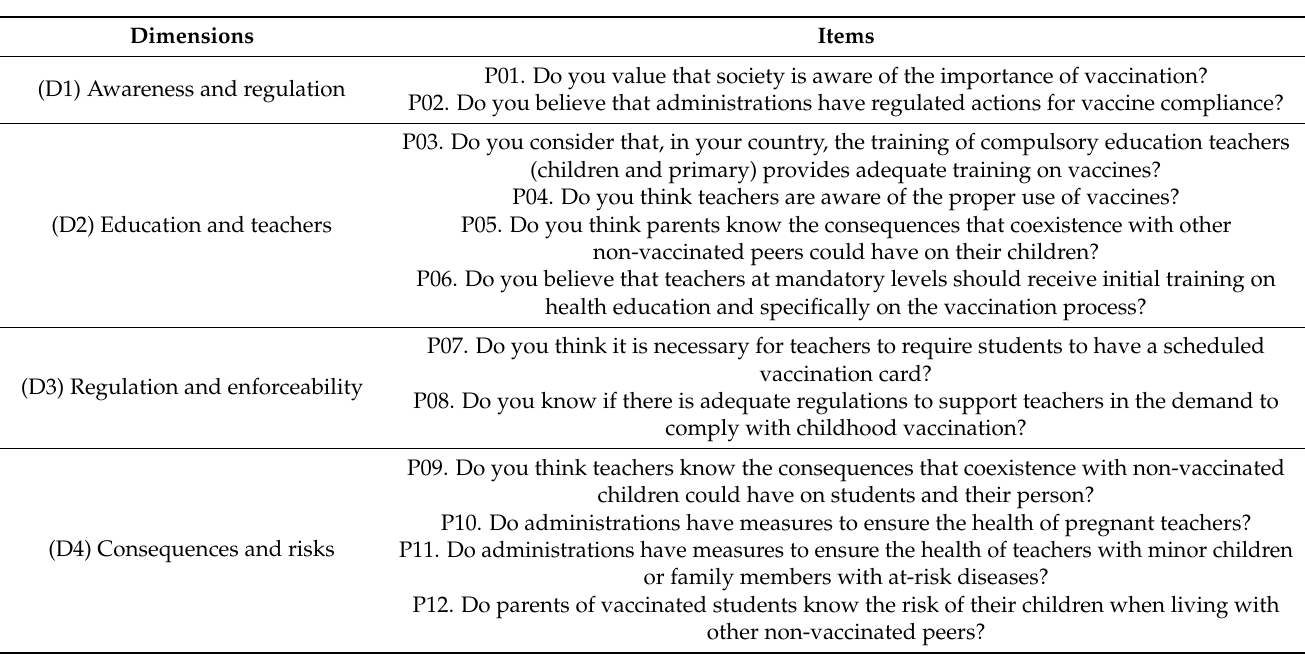
Table 2. Dimensions and items of the